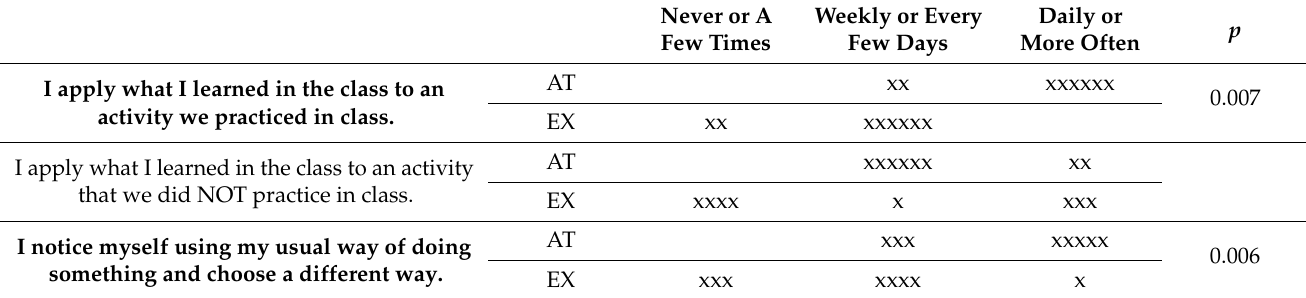
Table 3. Survey responses at second post-test